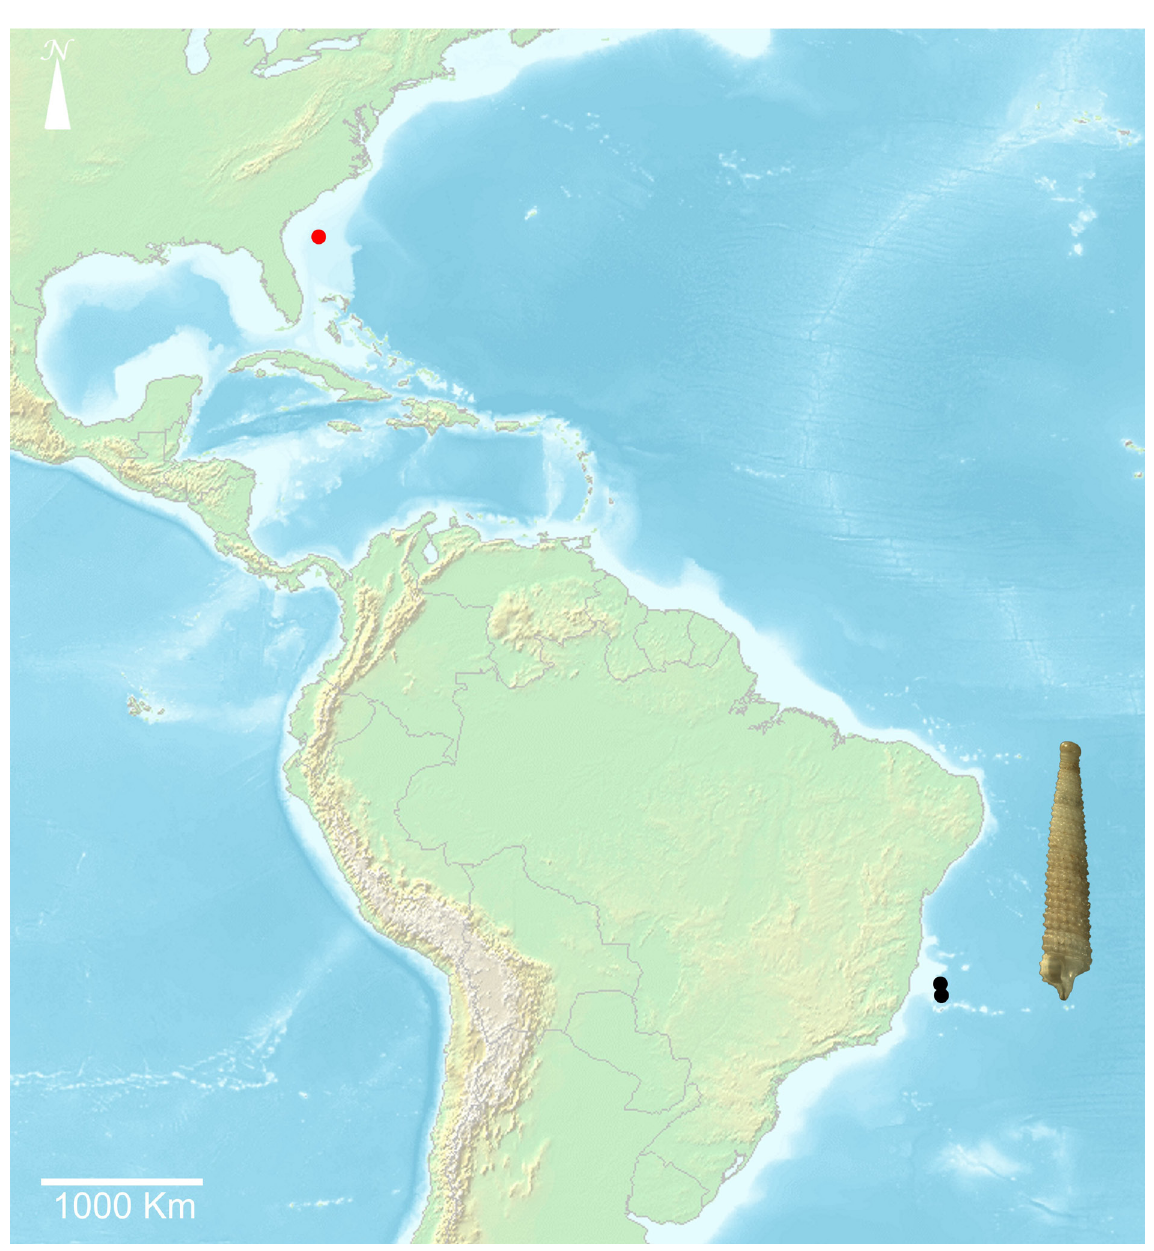
Fig. 69. Distribution map of Strobiligera dinea (Dall, 1927); red circle = type